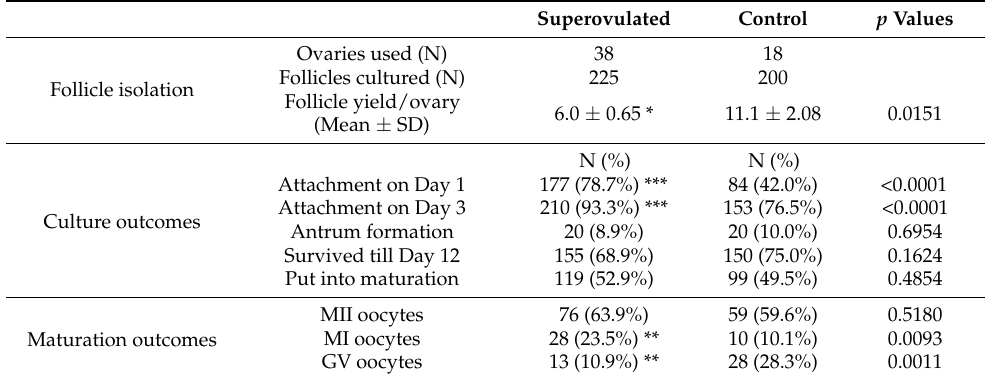
Table 1. Comparison of parameters reflecting follicular growth and oocyte maturation